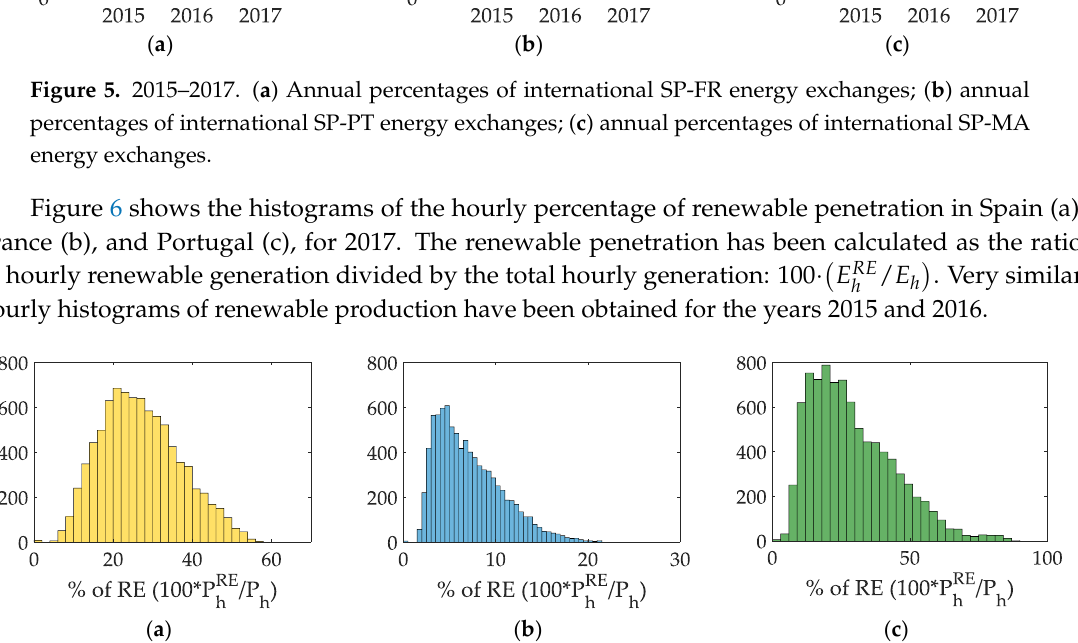
Figure 6. Histograms of the percentage of hourly renewable penetration, 100 · (𝐸 ℎ𝑅𝐸 /𝐸 ℎ ) , ( a ) in Spain; ( b ) in France; and ( c ) in Portugal, each for the year 2017.